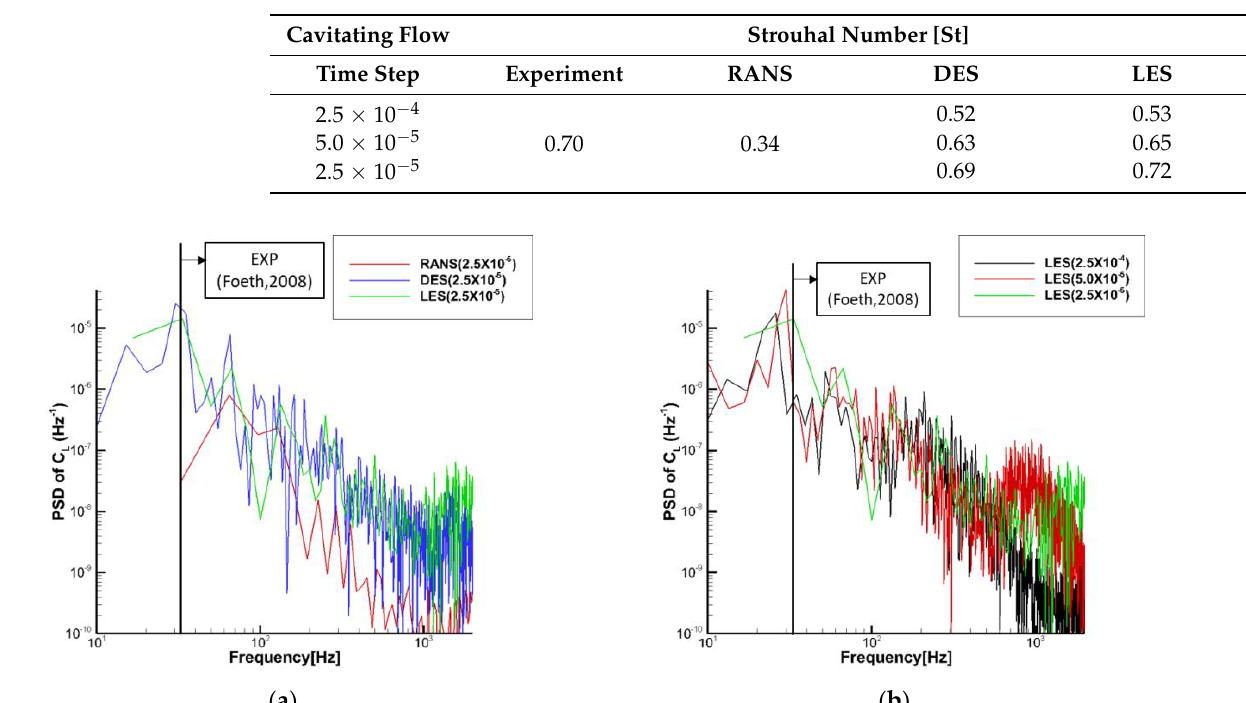
L ) according to turbulence model ( a ) and time step ( b